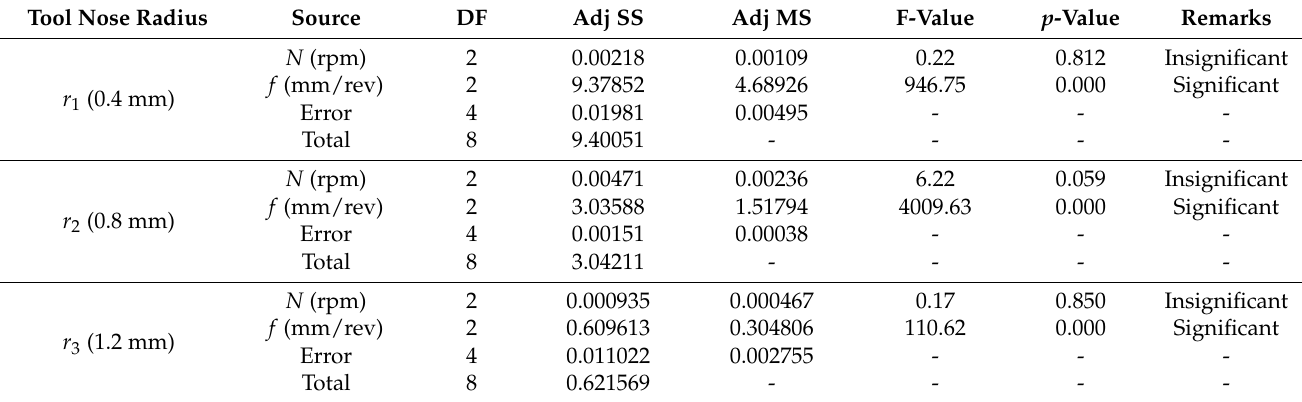
Table 3. ANOVA of surface roughness (R a ) for various tool nose radius.